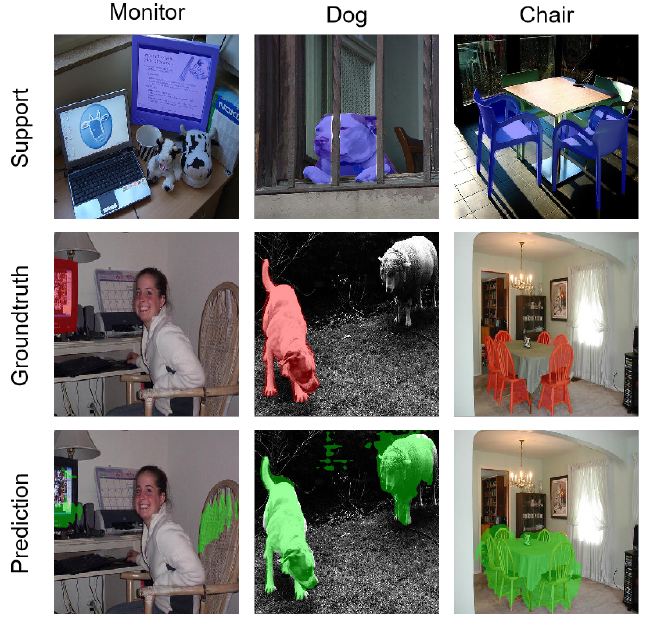
Figure 10. Segmentation results with semantic confusion problem in PASCAL-5 i